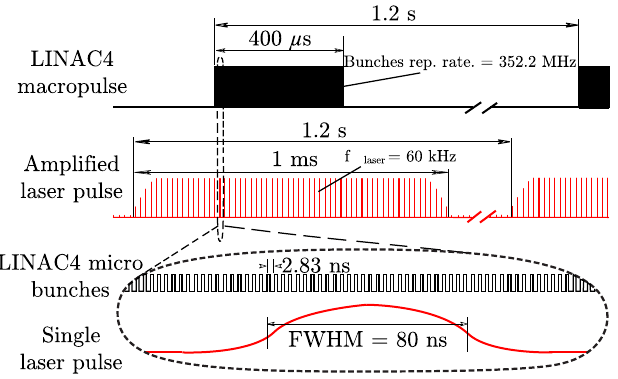
FIG. 6. Timing diagram of the laserwire